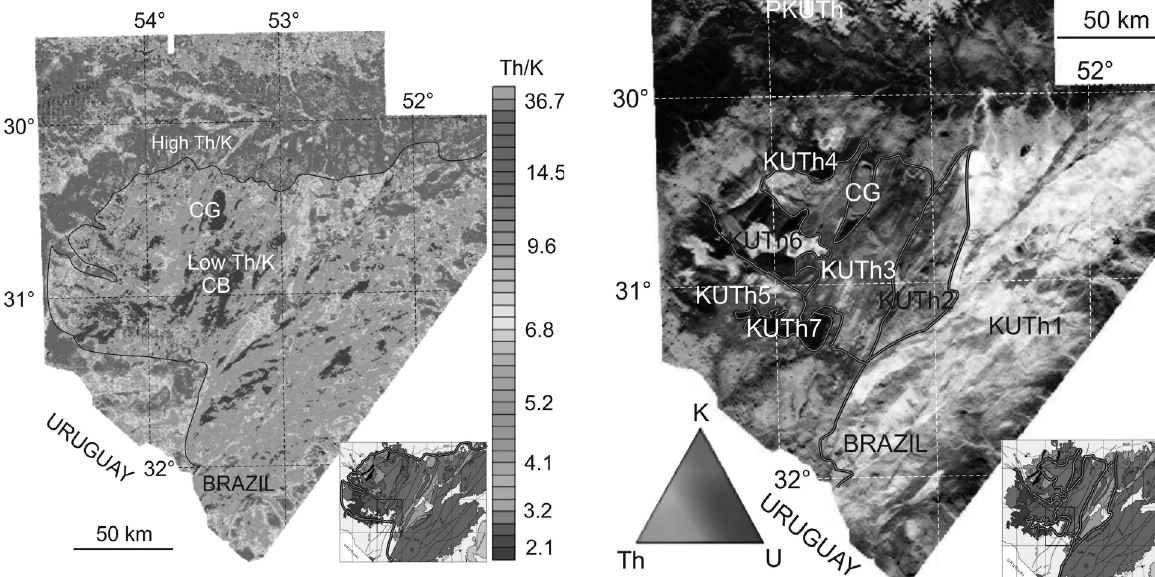
Figure 5 - Total K + eU + eTh provinces, the Sul-Riograndense Shield. Identi fi cation of major total K + eU + eTh provinces (e.g., KUTh7). KUTh6 = granitic plutons in the foreland. For interpretation of the references to color in this fi gure legend, the reader is referred to the web version of this